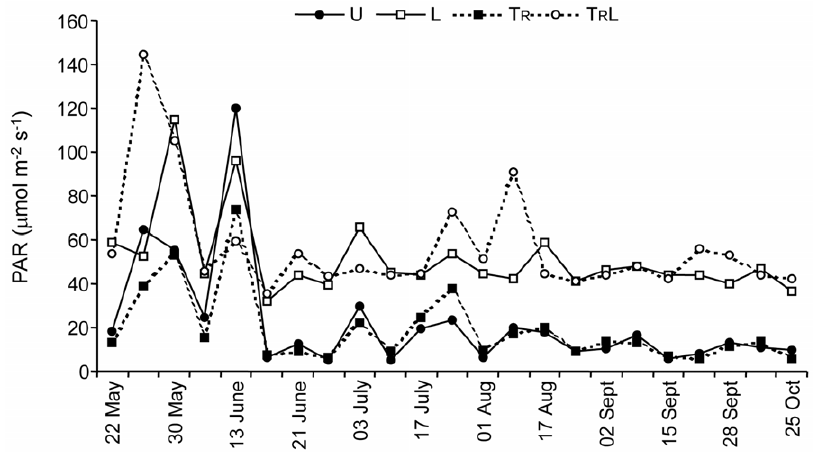
Figure 4. Light level in enclosures. Mean PAR (400–700 nm) values measured in unmanipulated (U), light (L), terrestrial invertebrate reduction (T R ), terrestrial invertebrate reduction 6 light (T R L) treatments throughout the study period. Error bars have been omitted for clarity.